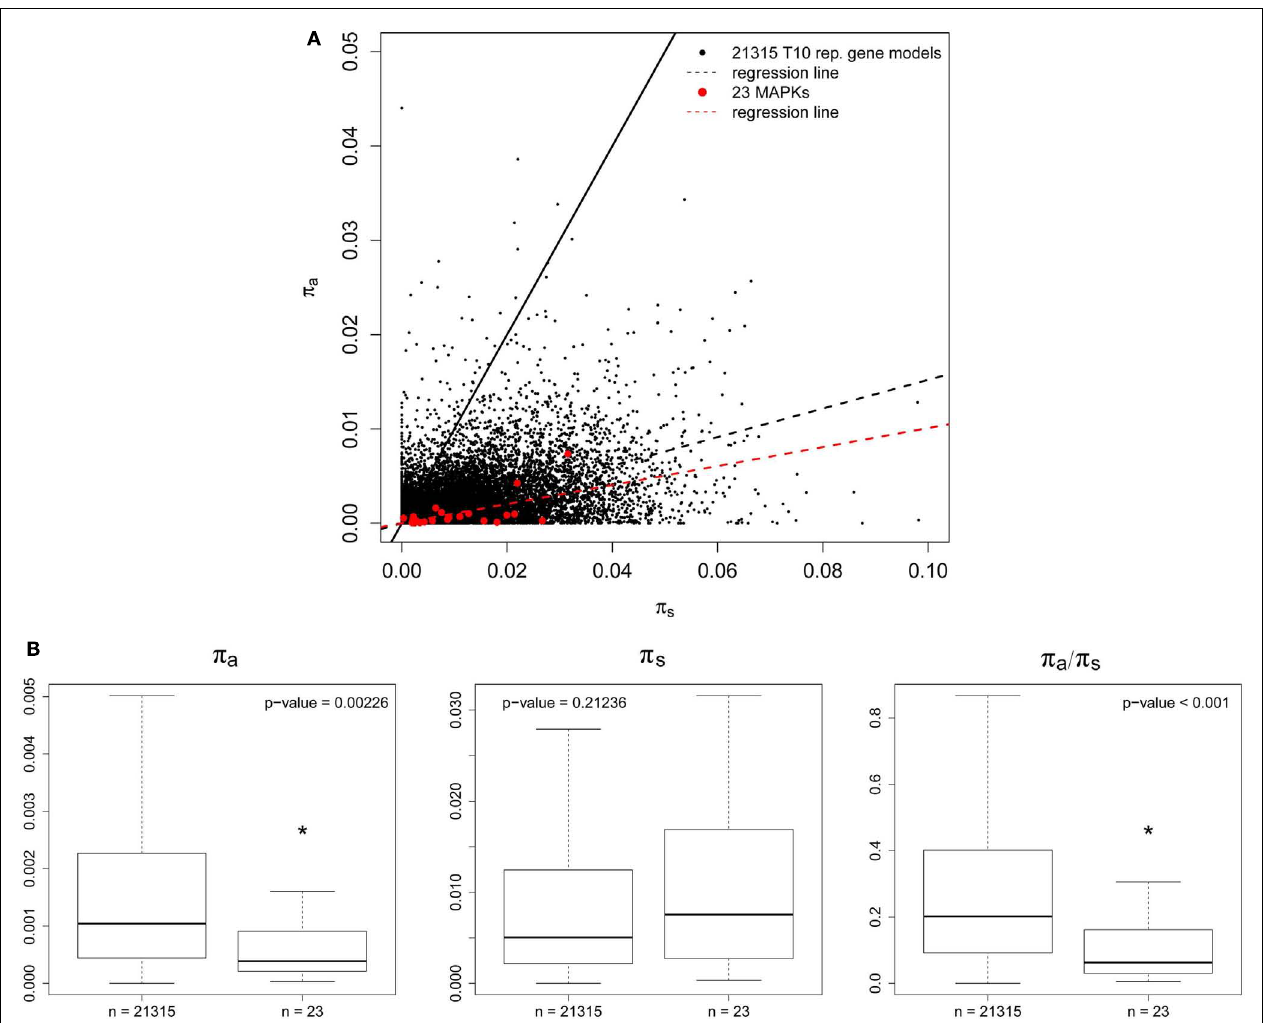
dashed red line represents the regression line for the MAPKs/MAPK-likes . (B) Boxplot for π a , π s , and π a / π s values of the 20 canonical MAPKs and the three MAPK-likes in comparison to the background data set. Medians are marked by solid black lines, boxes contain all data points in the 25–75% quartile range and whiskers denote 1.5x interquartile distances. Asterisks indicate significant differences (Wilcox